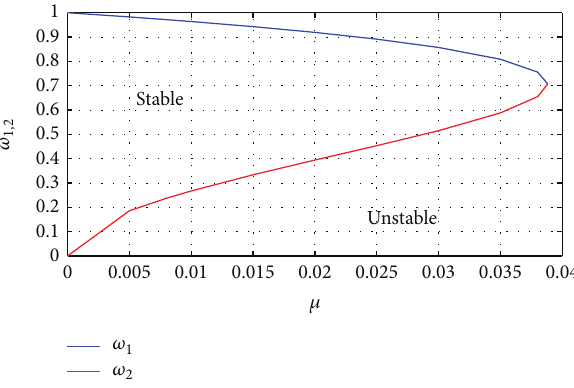
Figure 6: Correlation between 𝜇 and 𝜔 1,2 .